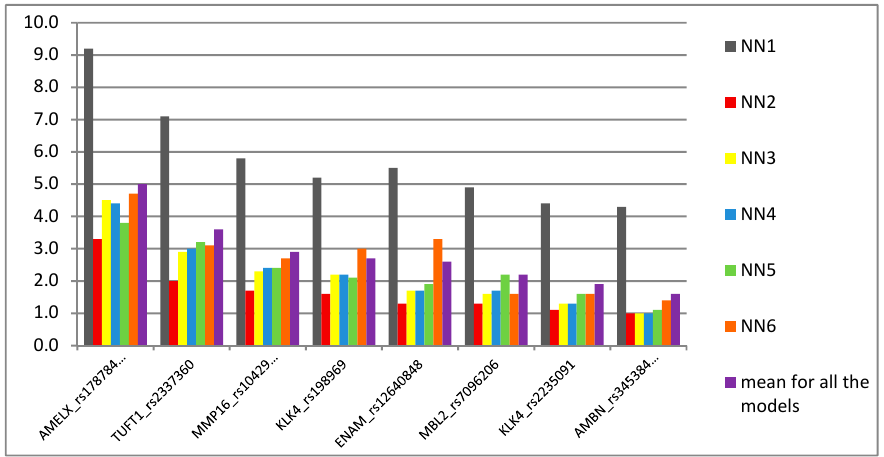
Figure 2. Prediction sensitivity for 8 SNPs used as predictors in neural network modeling. The higher the error rate value, the more sensitive the model is to the lack of a variable. The arrangement of the predictors in the figure is shown on the basis of the mean error value for the 6 neural network models (from NN1to NN6).